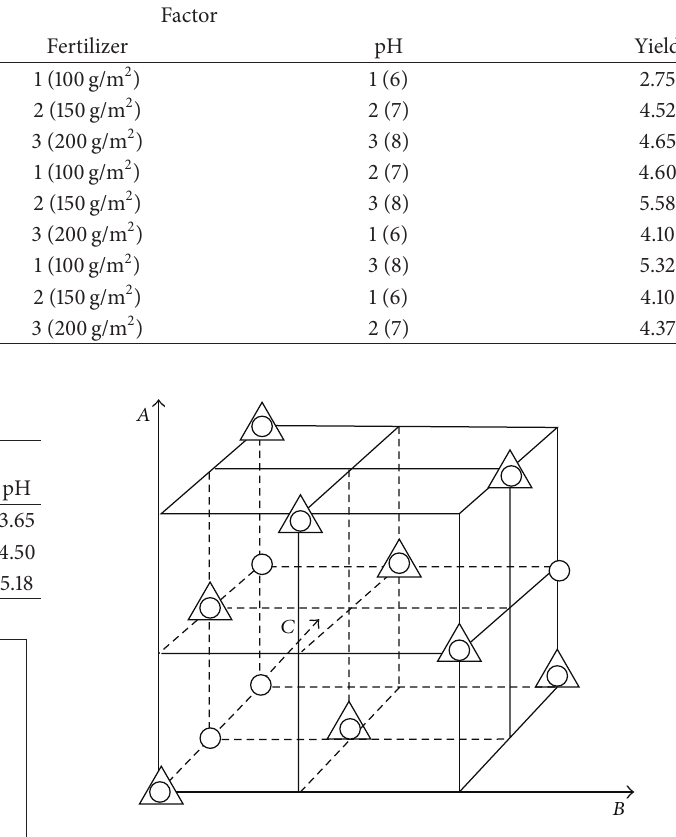
Table 2: The yield of nine representative combinations, based on the orthogonal array 𝐿 9 (3 3 ) .